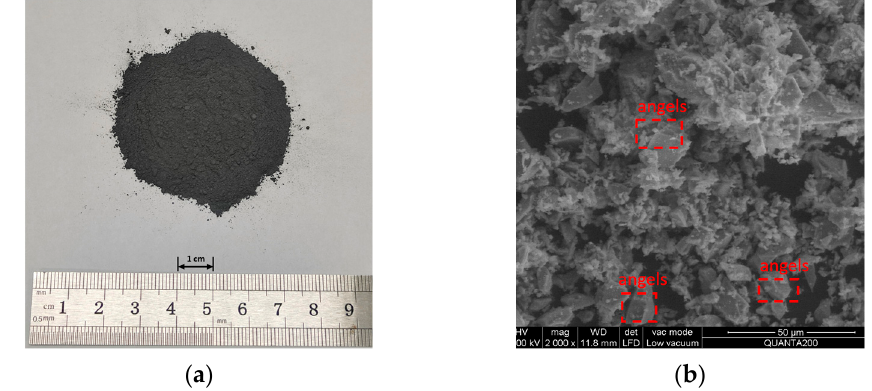
Figure 2. Fe 3 O 4 powder: ( a ) appearance, and ( b ) ESEM image of the Fe 3 O 4 powder. Table 3. Physical performance of fillers.